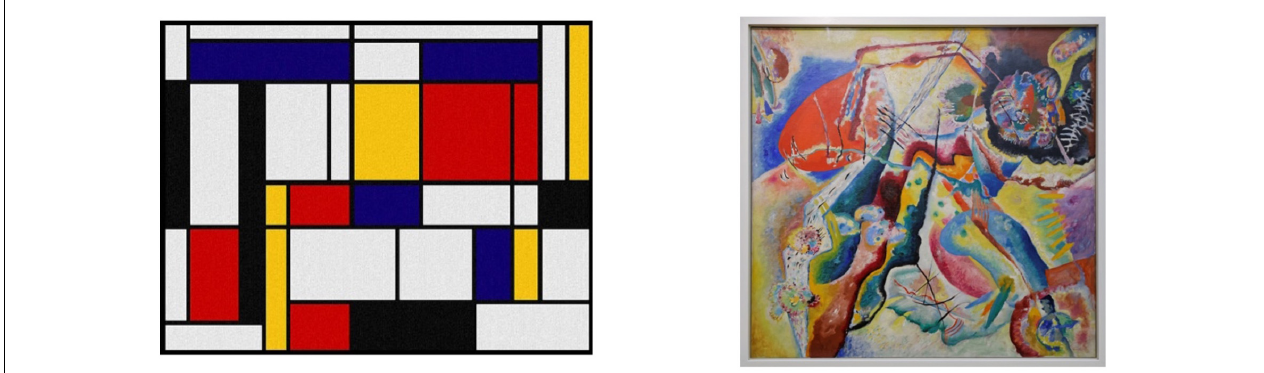
FIGURE 3 | An example of a Minimalist painting (left) : “Composition en rouge, jaune, bleu et noir” Piet Mondrian, and an Expressionist painting (right) : “Painting with red spot” Wassily